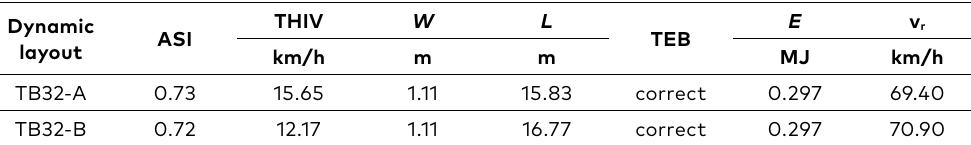
Figure 14. Comparison of ASI(t) graphs for TB32-A (solid line) and TB32-B (dotted line) Table 4. Comparison of results of analysed crash